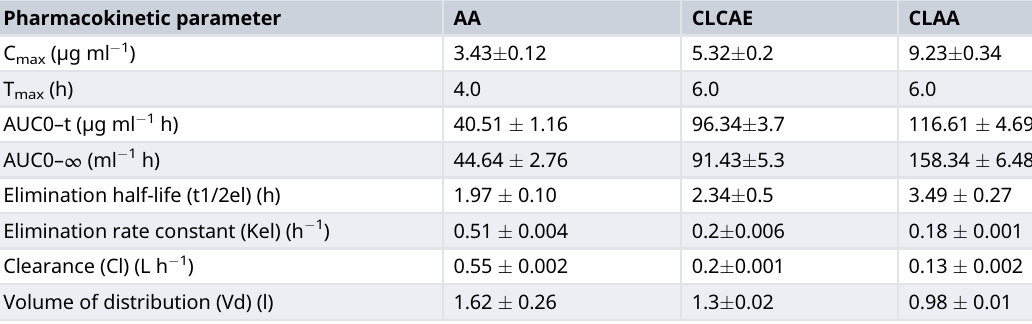
Table 5. Oral bioavailability study: Concentration of AA in rat